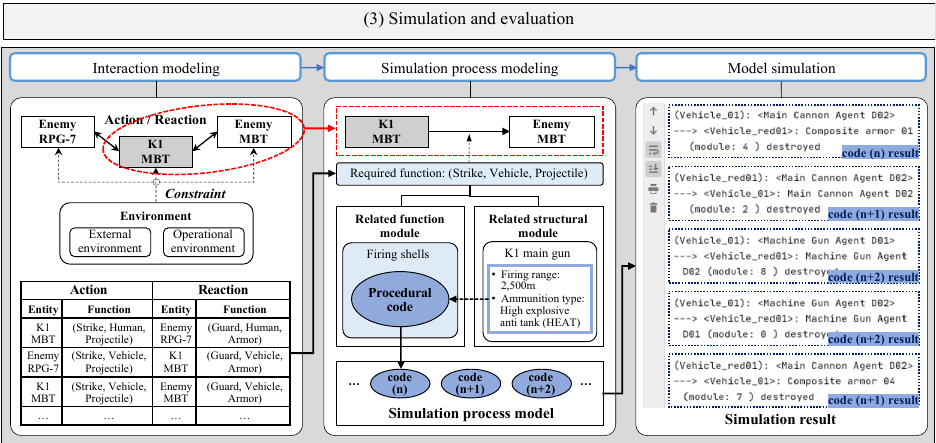
Figure 10. Flow of actions for simulation and